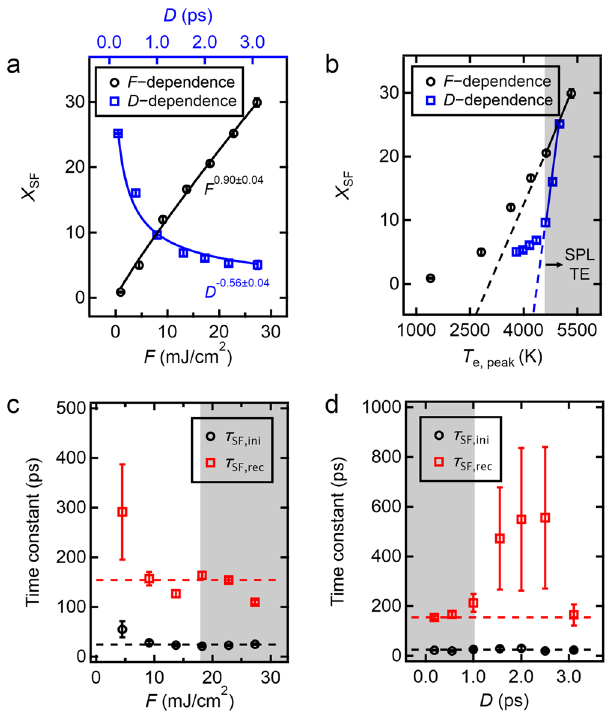
Fig. 2 Quantitative analysis of projection image intensity. a Surface fi eld- effect strength factor, X SF , as a function of F (black circles) at a fi xed D of 180 fs and a function of D (blue squares) at a fi xed F of 22.8 mJ cm − 2 . The power regression fi ts to the measured data are indicated by the black and blue curves. The exponent of the fi t is evaluated as 0.94 ± 0.02 and − 0.34 ± 0.01 for the F - and D -dependence measurements, respectively. b F - and D -dependence of X SF displayed as functions of the calculated peak electronic temperature, T e,peak . The black solid line is the calculated X SF of the F -series measurement with the analytical equation developed by Riffe et al. 10 , featuring a range of linear behavior above T e,peak ≅ 3000 K, and thus indicating the regime (white background) of space charge limited (SCL) thermionic emission (TE). The calculated X SF is scaled down by a factor of 0.35 to qualitatively match the fi rst fi ve data points (from the left) of the D -series, and shown as blue broken line. The blue solid line connecting the remaining three data points is drawn as guide to the eye. c , d Time constant of the initial, τ SF,ini (black circle), and recovery τ SF,rec (red square) phase as a function of F and D , respectively. The SCL TE regime is indicated by the white background region, determined in b . The broken horizontal lines indicate the weighted averages of τ SF,ini and τ SF,rec , which were used as fi xed parameters in the analysis of the diffraction data (see the main text). The error bars correspond to ±1 standard deviation of the fi tting